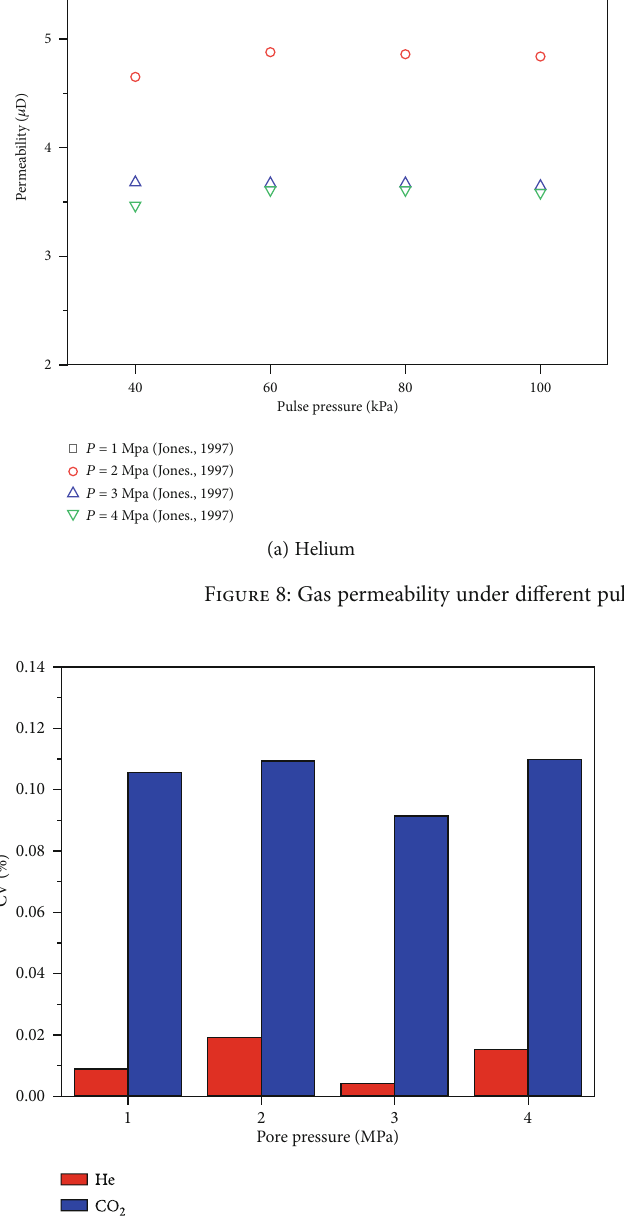
Figure 9: CV of the gas permeability measured by di ff erent pulse pressures under di ff erent pore